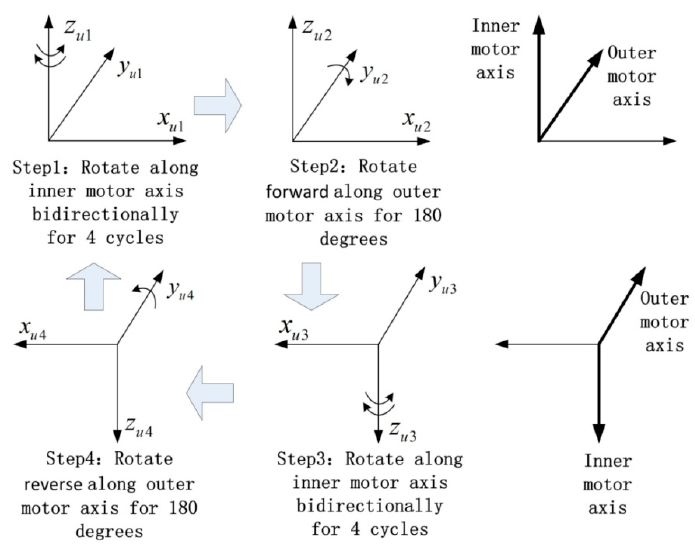
Figure 3. Process of rotation scheme.